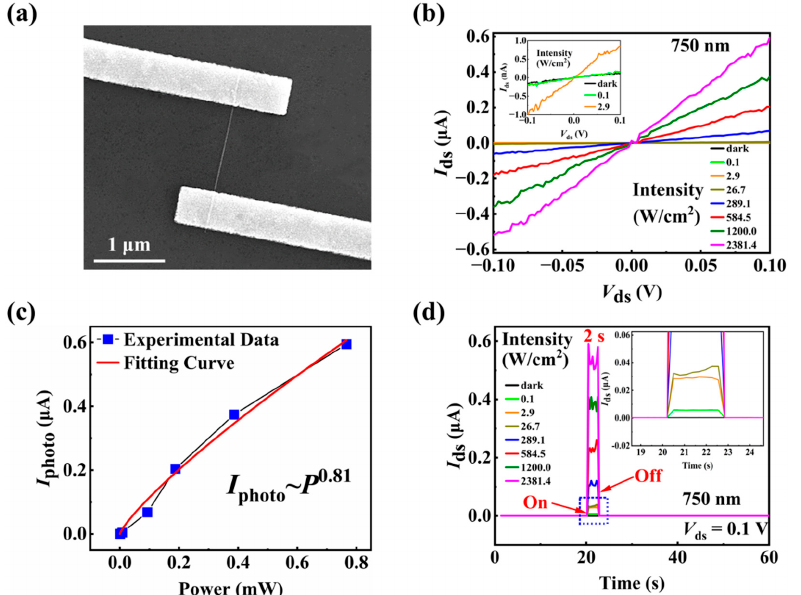
Figure 2. ( a ) Scanning electron microscopy (SEM) image of a typical InAs NW FET. ( b ) I ds - V ds curves in the dark and under 750 nm light illumination with different light intensities. The inset is the enlarged image showing the data with low current. ( c ) The relationship between photocurrent and incident light power. ( d ) The time-resolved current response to 750 nm light pulses with 2 s duration time and different light intensities. The inset is the enlarged image showing the data with low current.